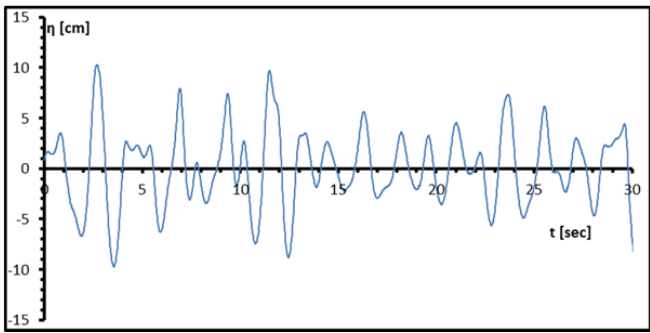
Figure 4. Water elevation η time series for Experiment #1. J. Mar. Sci. Eng. 2020 , 8 , x FOR PEER REVIEW